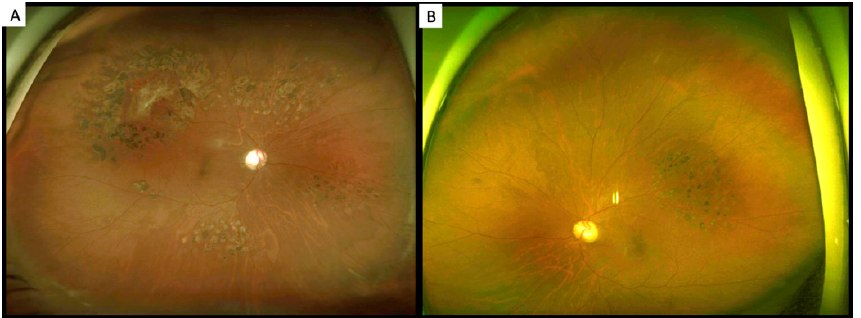
Figure 5. ( A , B ) No additional neovascular lesion or fibrovascular membrane formation in both eyes after two years follow up.